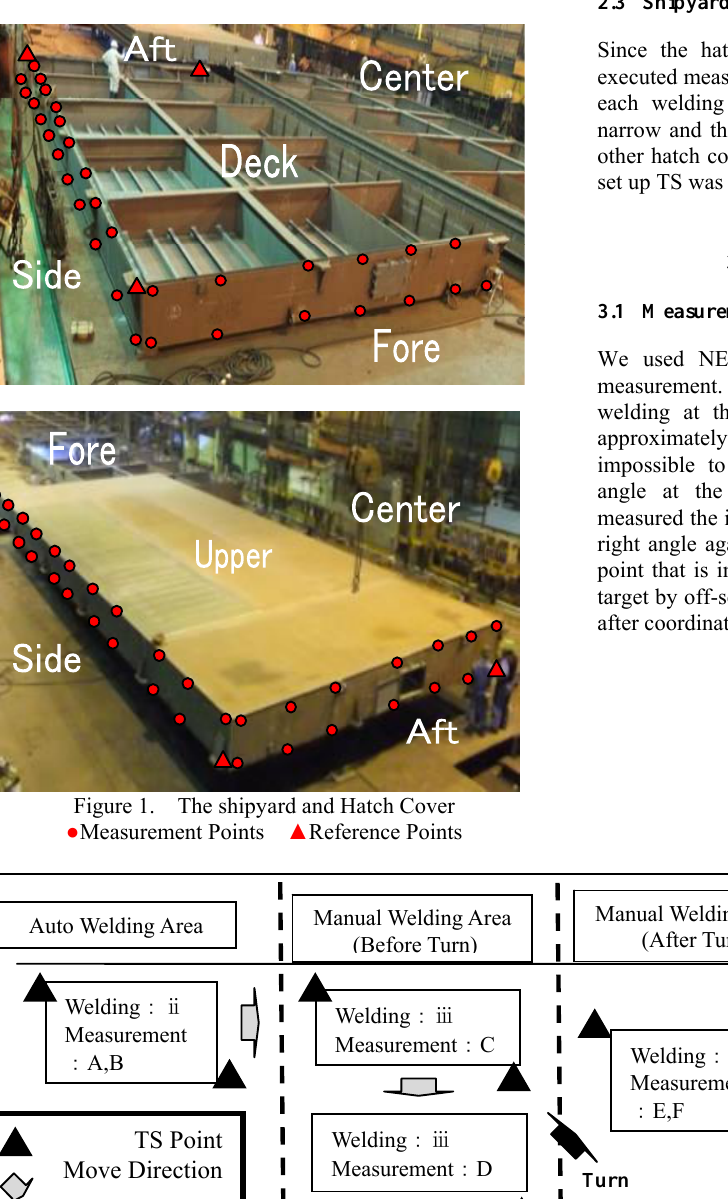
Figure 2. Hatch Cover Movement at